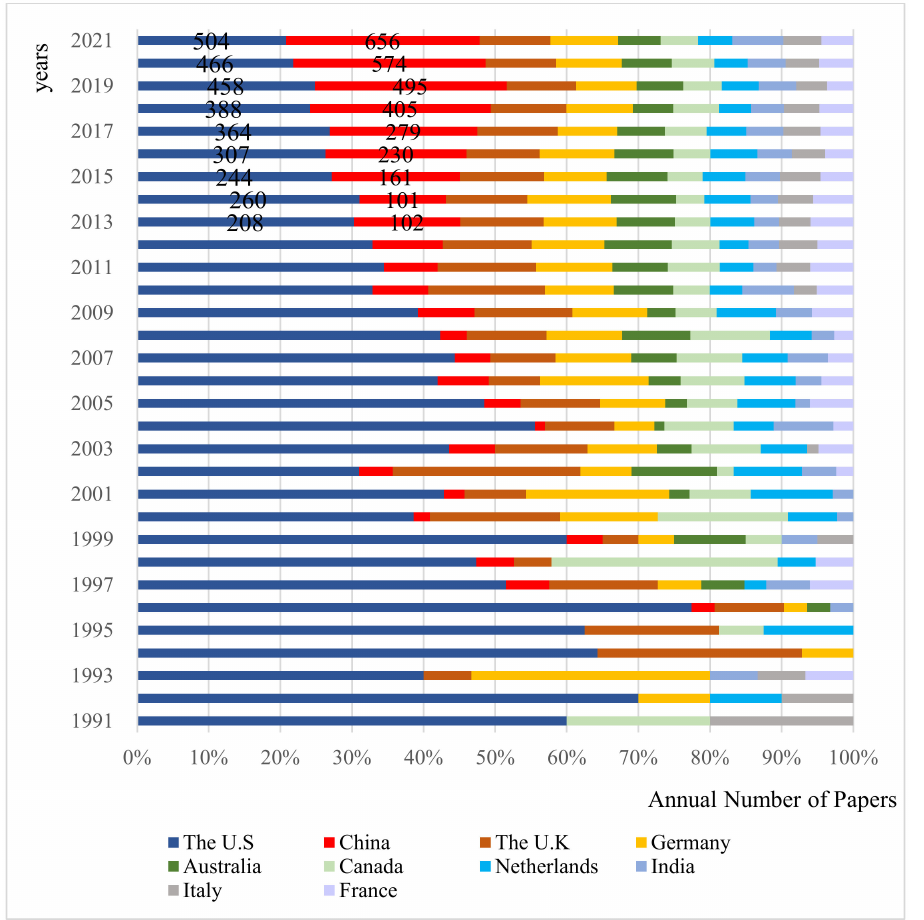
Figure 3. Annual Number of Papers Published by the Top Ten Countries/Regions in the Field of Carbon mitigation Research. Table 1. Top 10 Countries/Regions in the Field of Carbon mitigation Research. Country Number of Publications Degree of Cooperative Network Intensity The USA 4213 132 China 3180 104 The UK 1686 125 Germany 1479 112 1076 101 896 93 828 97 795 93 731